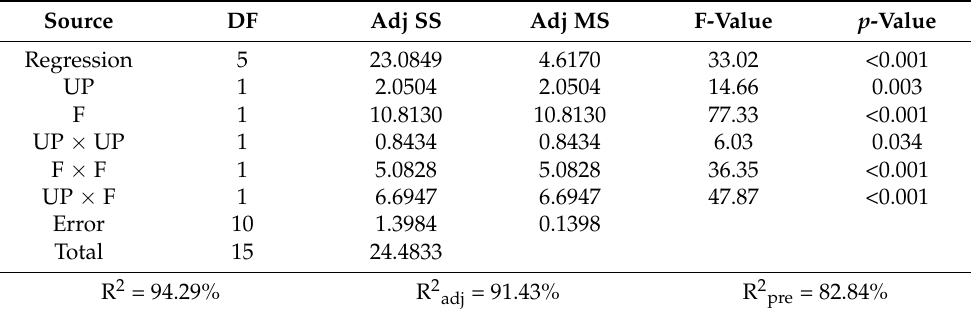
Table 6. Variance analysis of the hardness.